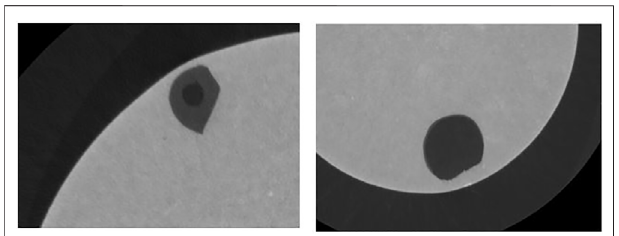
light grey is steel, medium grey is the inclusion/slag phase and the dark grey/ black is